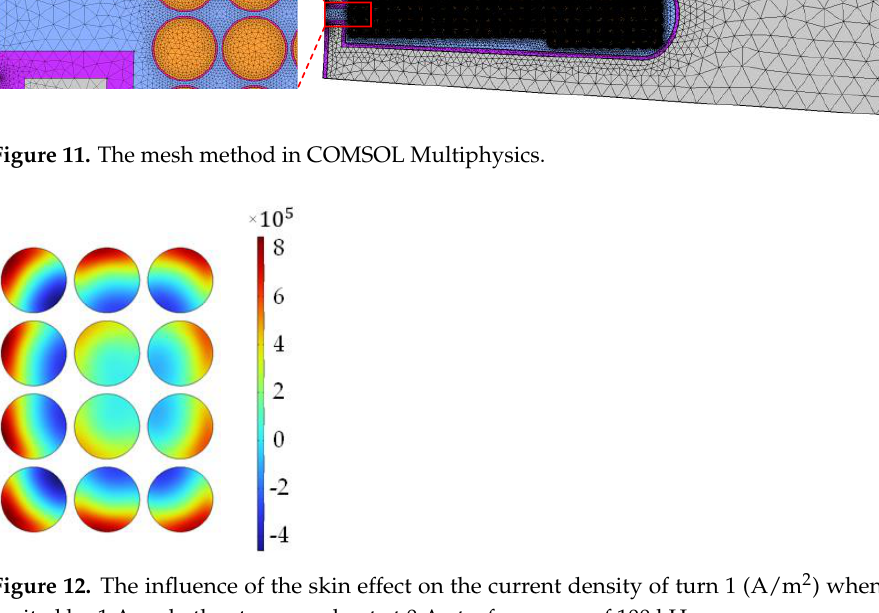
Figure 11. The mesh method in COMSOL Multiphysics.